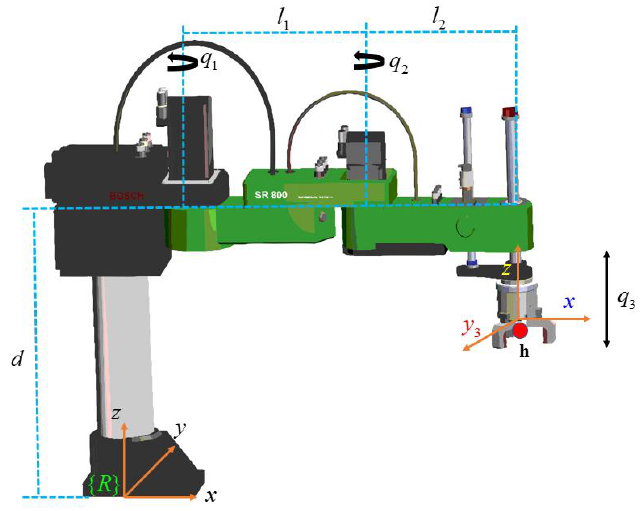
Figure 6. Scara SR-800 Industrial Robot.